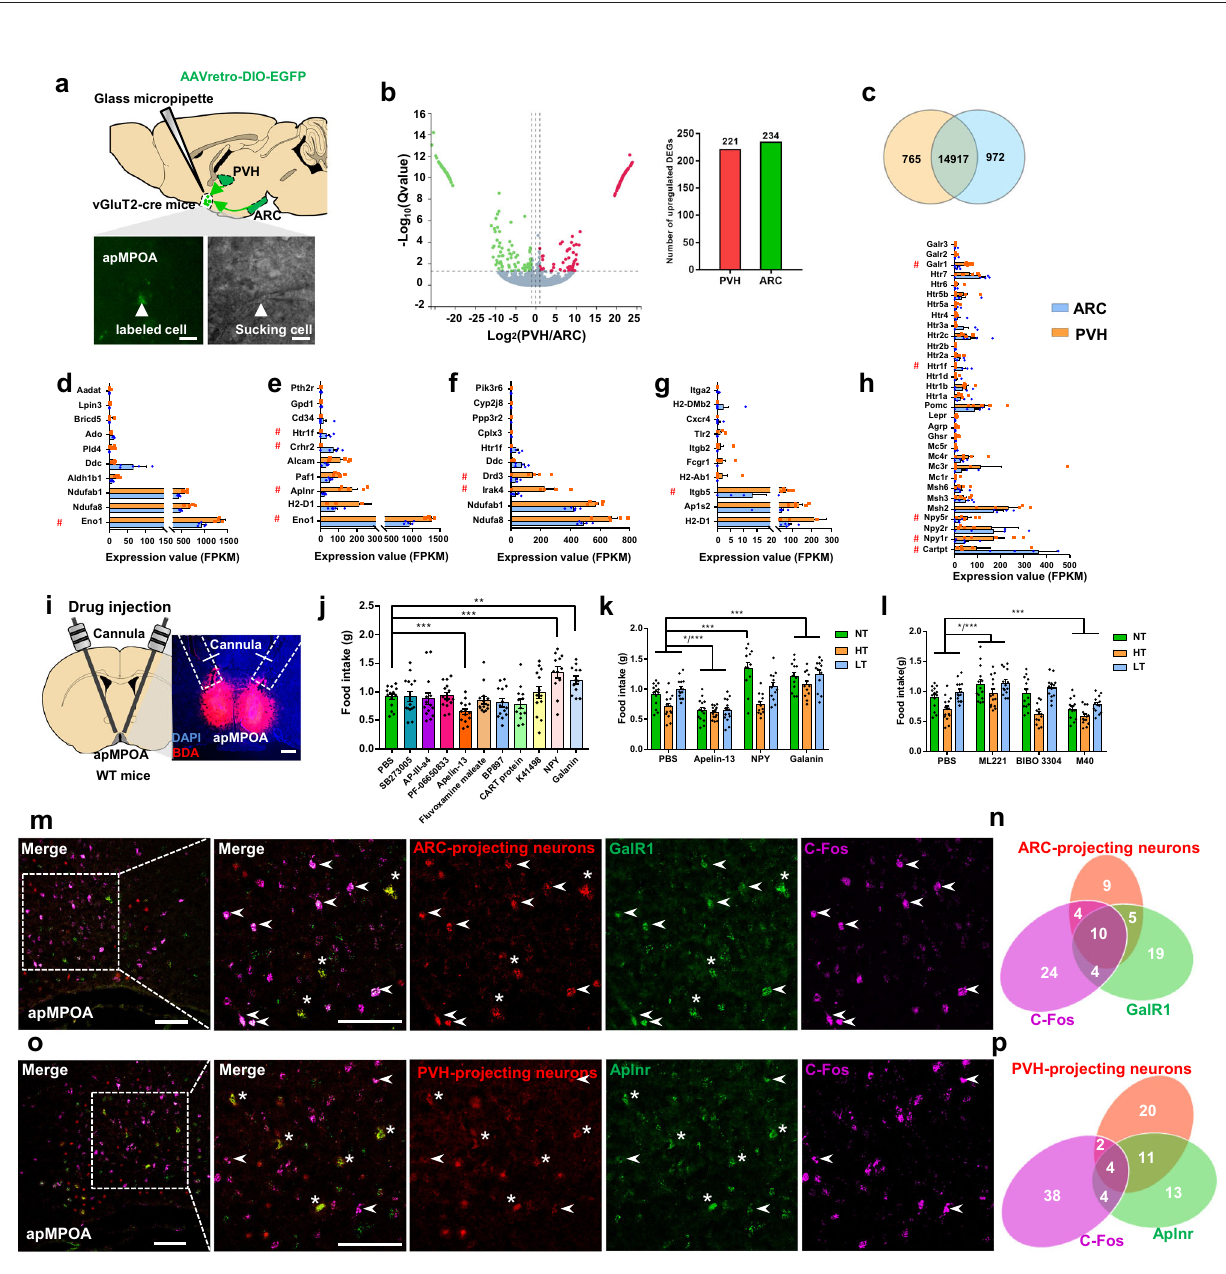
Fig. 7 Retrograde labeling for the two subsets of anatomically differentiated PVH and ARC-projecting apMPOA neurons. a Schematic and representative coronal images of the injection of CTB 488 and CTB 555 into PVH and ARC of wild type mice respectively. Image representative of n = 5 mice. Scale bar, 100 µ m. b , c Colocalizations of retrograde-labeled neurons in the apMPOA from the PVH (green) and ARC (red), n = 5 animals for each group (a total of 8 mice models were made with 3 mice excluded due to missed injection). Scale bar, 100 µ m. d Schematic and representative coronal images of the injection of Cre-dependent AAVretro vector expressing RV helpers into the PVH or ARC on day 1 and RV-EnvA- Δ G-dsRed on day 21 into the apMPOA of vGluT2-cre mice. Image representative of n = 4 mice. Scale bar, 100 µ m. e Quanti fi cation of numbers of retrogradely labeled cells in different regions in ipsilateral sides of the injected apMPOA. n = 4 animals for each group (a total of 6 mice models were made with 2 mice excluded due to missed injection). f Typical coronal images of DsRed-expressing neurons in posterior part of the BNST (pBNST), LPBd, NTS, and BA in the group with RV helpers- injection into the PVH. Image representative of n = 4 mice. Scale bar, 100 µ m. g Typical coronal images of DsRed-expressing neurons in LPBe, but sparse neurons in the pBNST, NTS and BA in the group with RV helpers-injection into the ARC. Image representative of n = 4 mice. Scale bar, 100 µ m. All error bars show SEM.